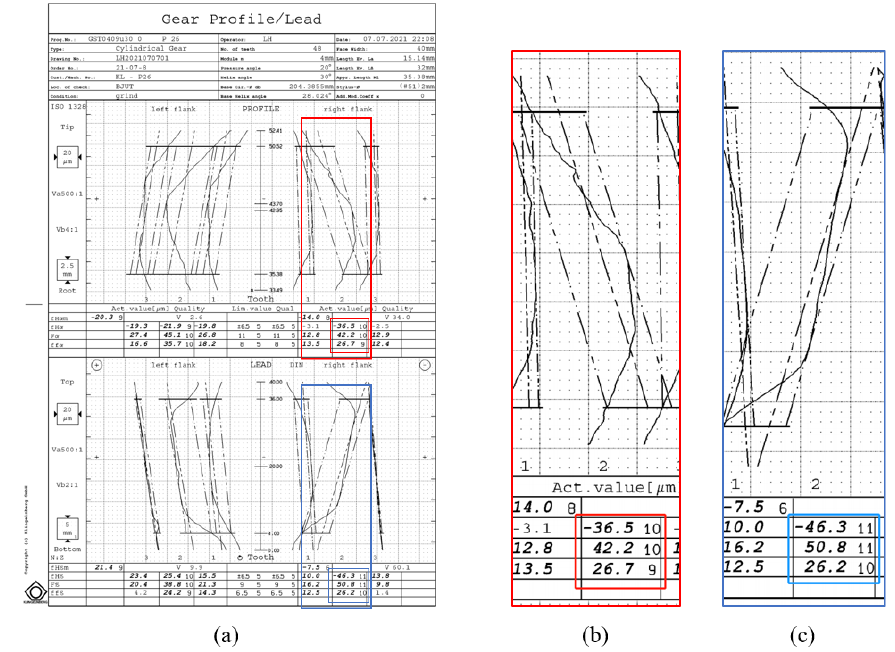
Figure 12. Measurement results of P26: ( a ) gear profile/lead; ( b ) local enlarged view of gear profile, and ( c ) local enlarged view of gear lead. Table 2. Comparison